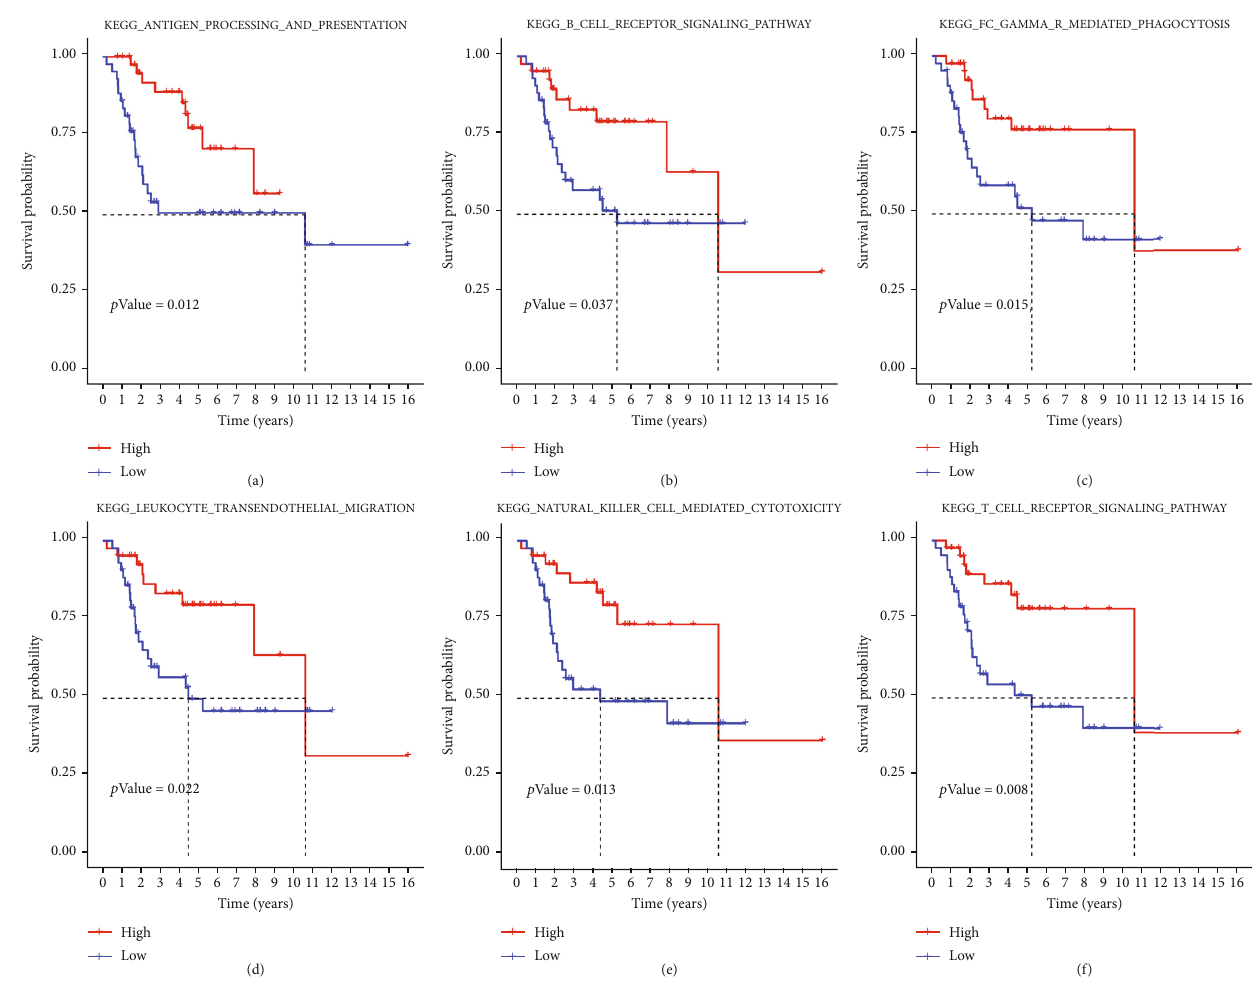
Figure 2: Immune signaling pathways associated with survival in OS